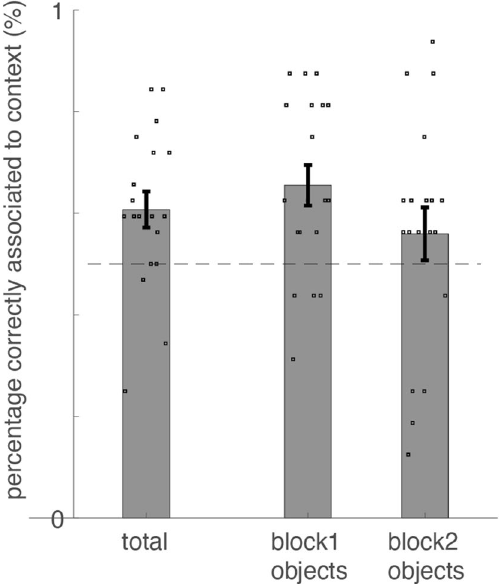
Figure 5. Percentage of correct responses during the neurofeedback context test. Average (± SEM) percentage of correct responses during the neurofeedback context test (overlaid with individual responses). Blocks are labeled block 1 and 2 since it is counterbalanced across participants which of the two blocks is face neurofeedback and which is scene neurofeedback. From left to right: average across all objects, average across those objects studied during neurofeedback block 1, average across those objects studied during neurofeedback block 2. One subject was an outlier and therefore excluded (i.e. more than 2.5 SD from group mean). Total: T (1,18) = 3.007, P = 0.008.